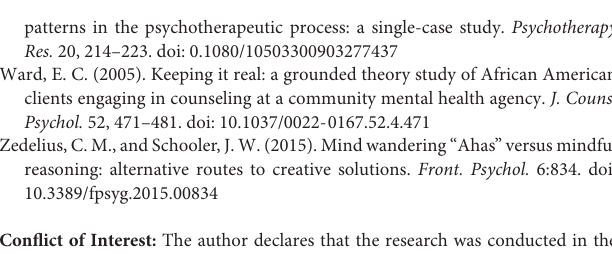
reasoning: alternative routes to creative solutions. Front. Psychol. 6:834. doi: 10.3389/fpsyg.2015.00834 Conflict of Interest: The author declares that the research was conducted in the absence of any commercial or financial relationships that could be construed as a potential conflict of